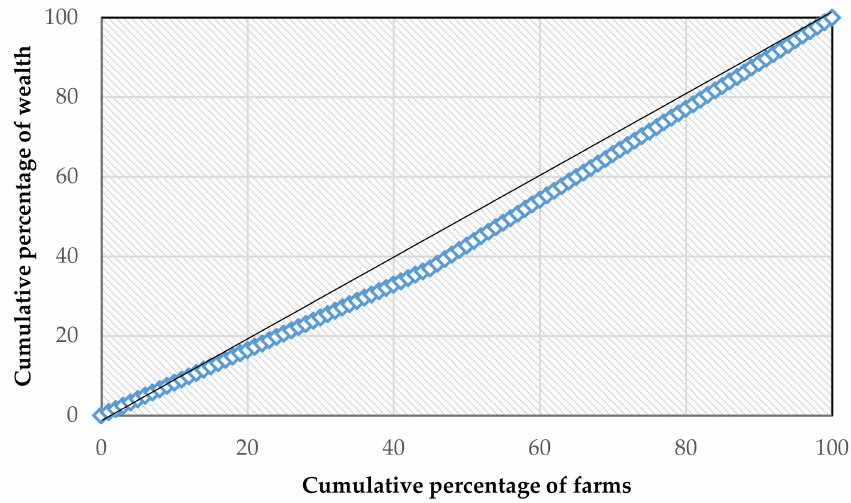
Figure 6. Lorenz curve for optimised values, technical efficiency improvement after penalisation and reallocation of reduced over-consumed water quantities. Source: Own elaboration based on model results